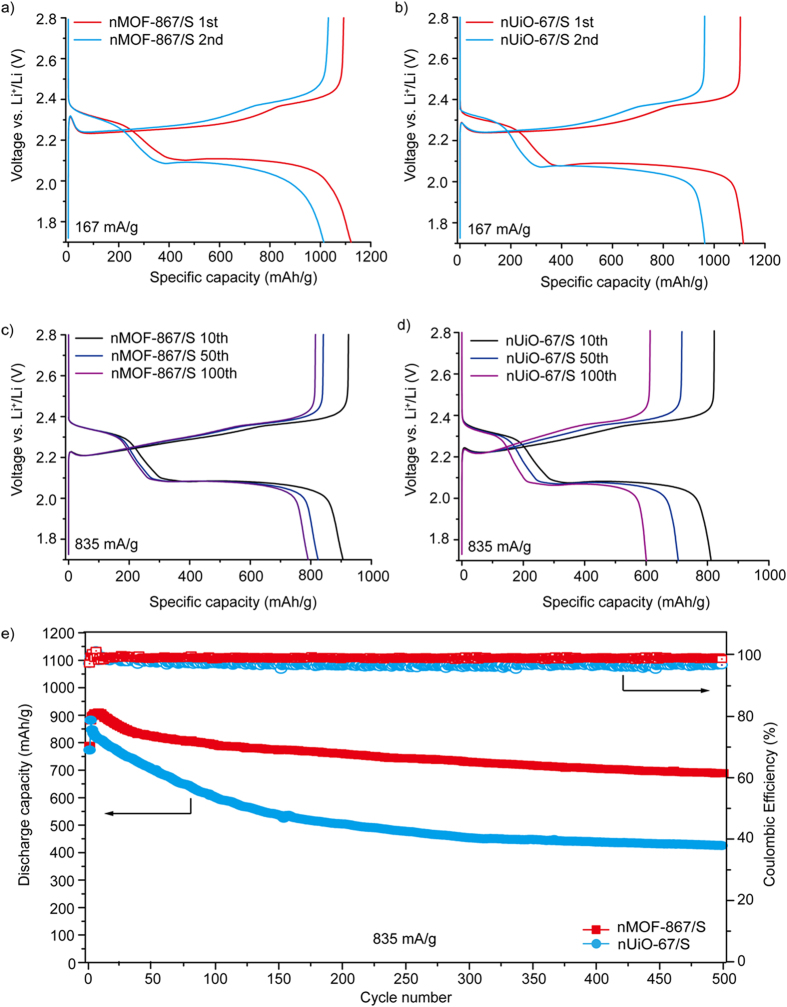
Electrochemical performance of nMOF-867/S and nUiO-67/S.(a) 1st and 2nd discharge/charge profiles of nMOF-867/S (at 167 mA/g). (b) 1st and 2nd discharge/charge profiles of nUiO-67/S (at 167 mA/g). (c) 10th, 50th and 100th discharge/charge profiles of nMOF-867/S (at 835 mA/g). (d) 10th, 50th and 100th discharge/charge profiles of nUiO-67/S (at 835 mA/g). (e) Long-term cycle performance over 500 cycles for nMOF-867/S and nUiO-67/S with a constant current of 835 mA/g.